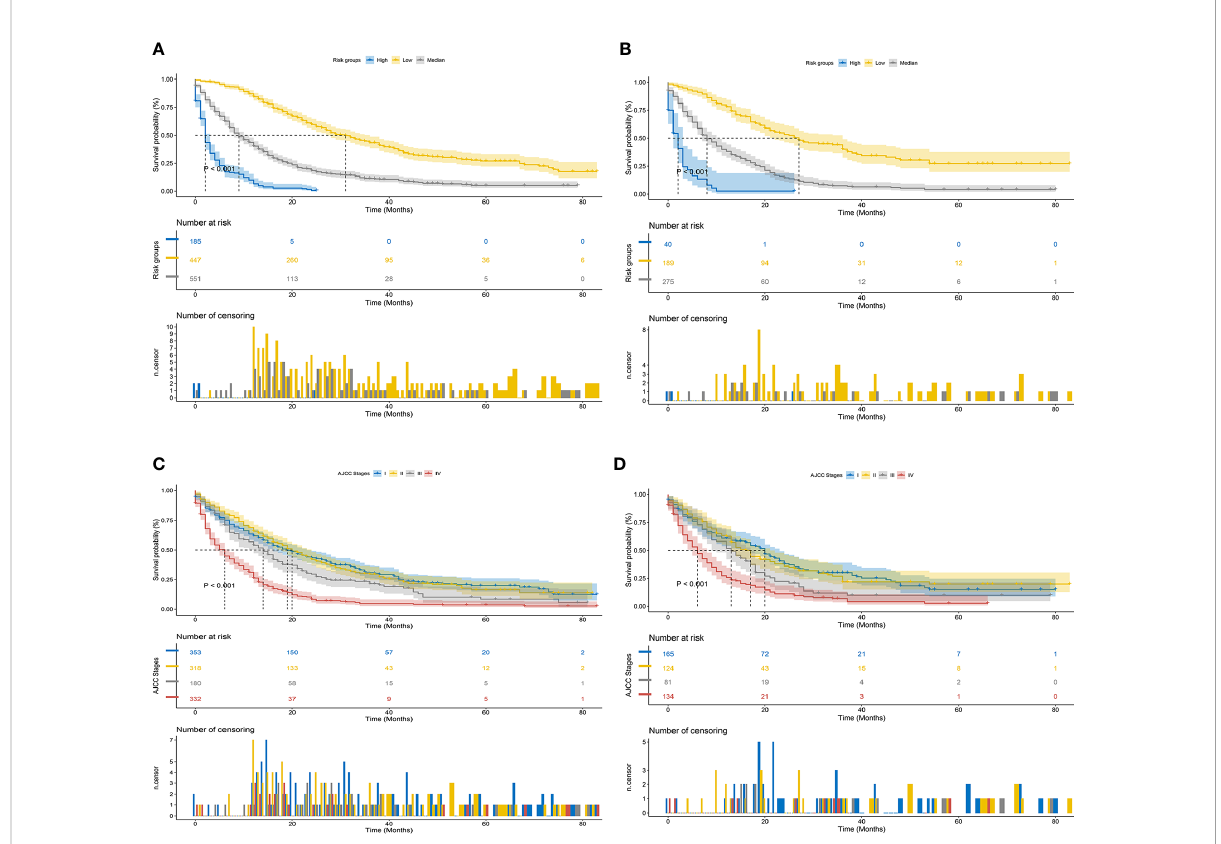
FIGURE 8 Kaplan – Meier CSS curves of patients with ECCA based on different criteria. (A, B) Kaplan – Meier CSS curves of the training and validation cohorts based on the new risk strati fi cation system. (C, D) Kaplan – Meier CSS curves of the training and validation cohorts based on AJCC staging